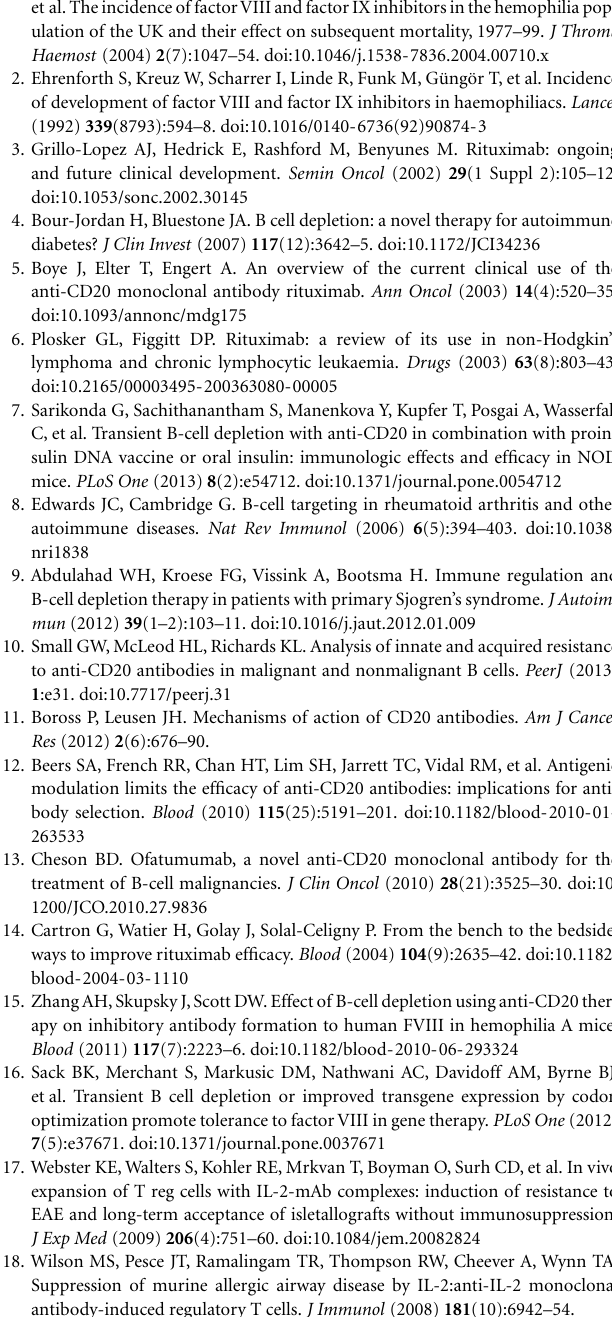
Figure S2 | Effects of immunomodulation on bothT and B-cells isolated from spleens of each treated mouse group . Spleen (A–C) cells were collected and isolated at serial time points from naive (light slant), FVIII plasmid only (white), anti-CD20 + FVIII (light gray), IL-2/IL-2mAb complexes + rapamycin + FVIII (dark gray), and IL-2/IL-2mAb complexes + rapamycin + anti-CD20 + FVIII (black) treated mice ( n = 2, each group). Cells were stained and analyzed forT-cell populations (A,B) and B-cell populations (C) . Data shown is representative of two independent